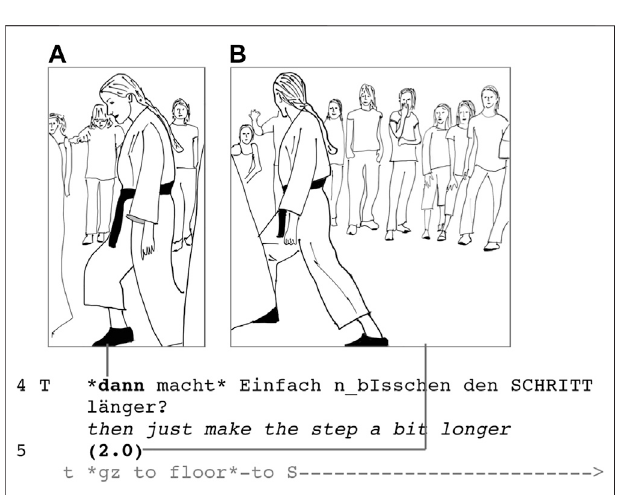
FIGURE 2 | “ So ” / “ like this ” , gaze shift and pointing mark the focal moment.